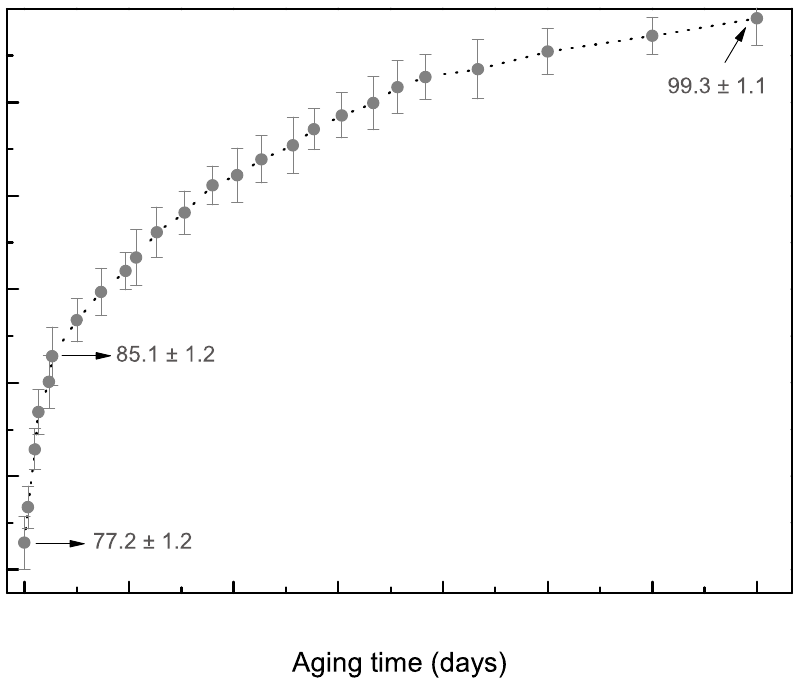
Figure 8. Variation in the hardness of the Al6Cu5Zn as a function of the natural aging process. Binary Al-Cu alloys have relatively stable mechanical properties after a few days.